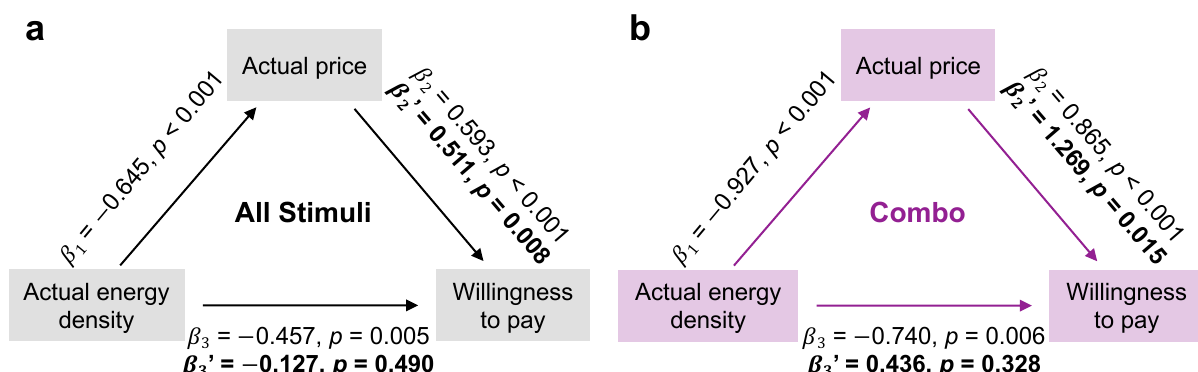
Figure 5. Food price mediates the negative association between energy density and WTP across all stimuli and in combo foods. ( a ) As energy density was separately associated with food price ( β 1 ) and WTP ( β 3 ), and price was also related to WTP ( β 2 ) across all stimuli, we tested whether price mediates the negative relationship between energy density and WTP. Indeed, the relationship between energy density and WTP ( β 3 (cid:48) ) was no longer significant when the indirect effect of price was accounted for in the regression model, which itself remained significant ( β 2 (cid:48) ) . ( b ) Actual food price also mediates the association between energy density and WTP when restricted to combo foods. Each β refers to a standardized beta coefficient.